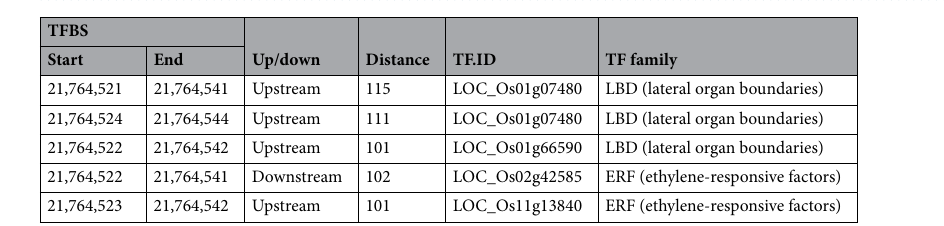
Table 2. Summary of TFBSs located near the cis -regulatory target gene of lncRNA.2-FL.